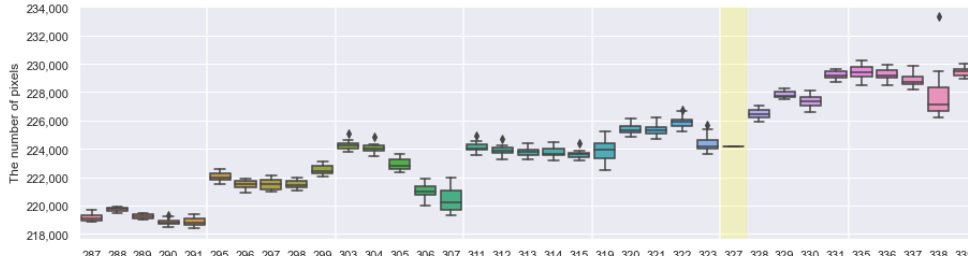
Figure A5. 10–16 September.